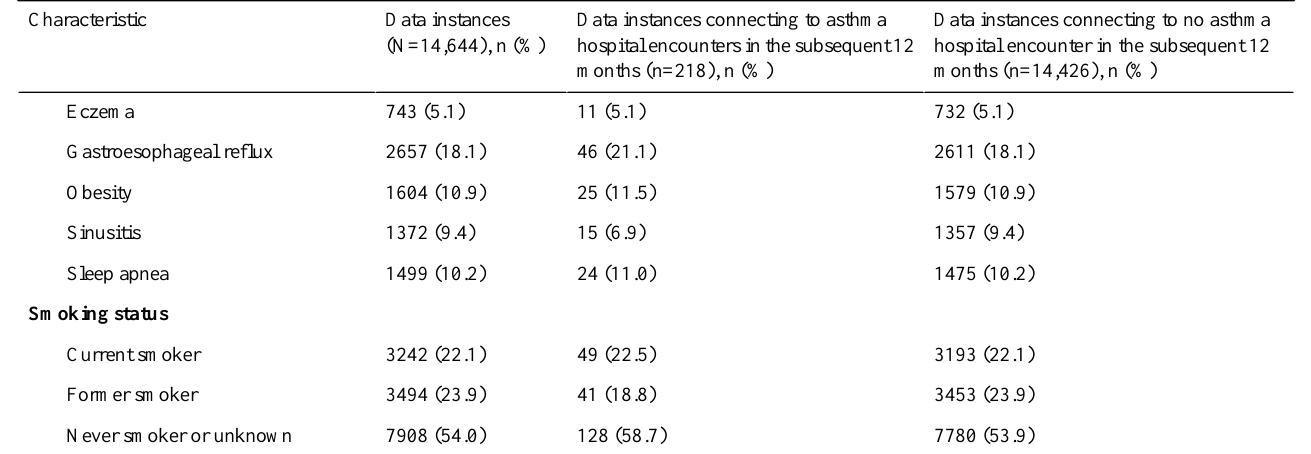
Table 4. The number of patients with asthma and their number of visits in each year between 2011 and 2018.